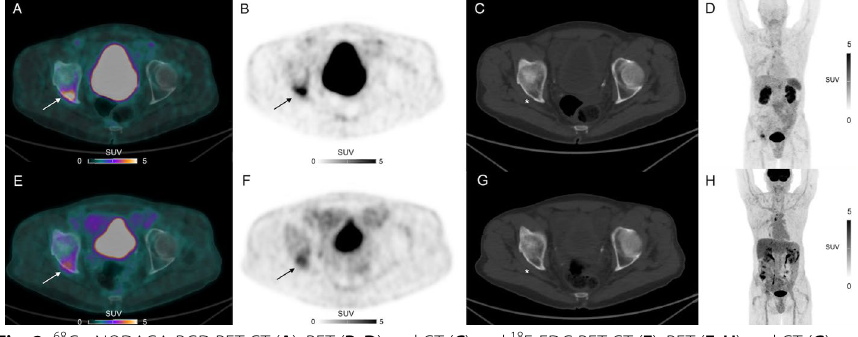
Fig. 2 68 Ga-NODAGA-RGD PET CT ( A ), PET ( B , D ) and CT ( C ) and 18 F-FDG PET CT ( E ), PET ( F , H ) and CT ( G ) axial views showing more intense 68 Ga-NODAGA-RGD uptake compared with 18 F-FDG uptake (arrows) of an osteolytic lesion (asterisks) of a 63-year-old participant with a metastatic esophageal adenocarcinoma